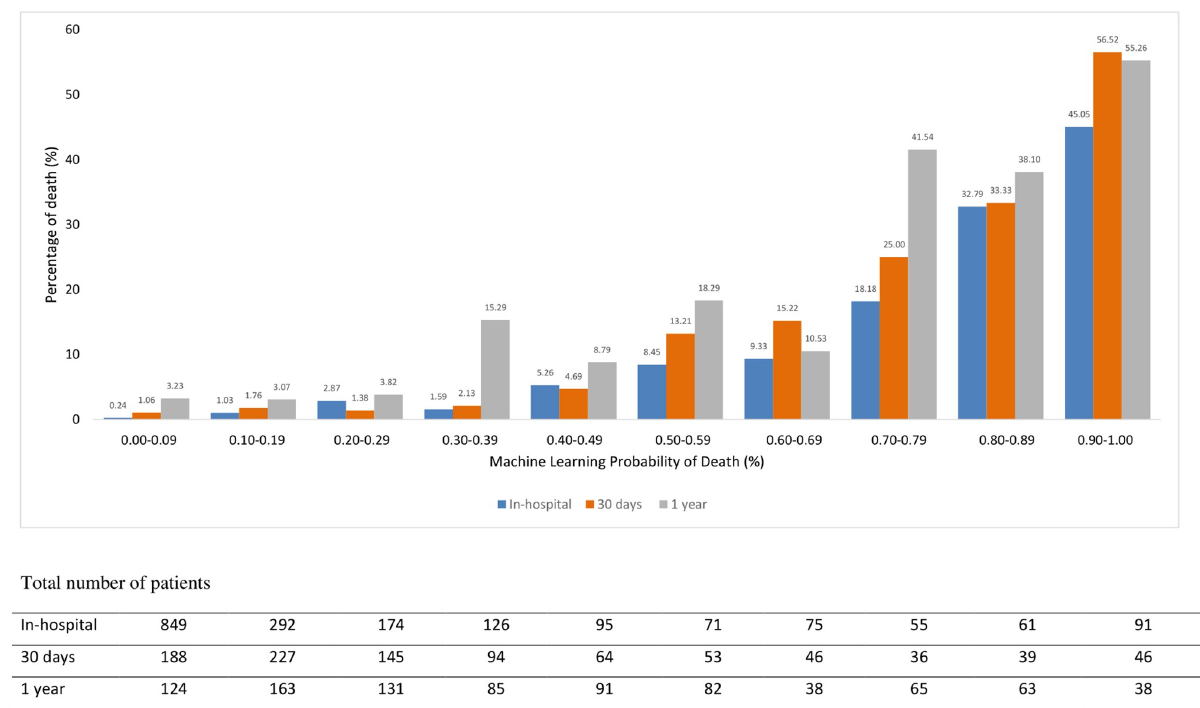
Fig 3. The rate of death across ML probability of